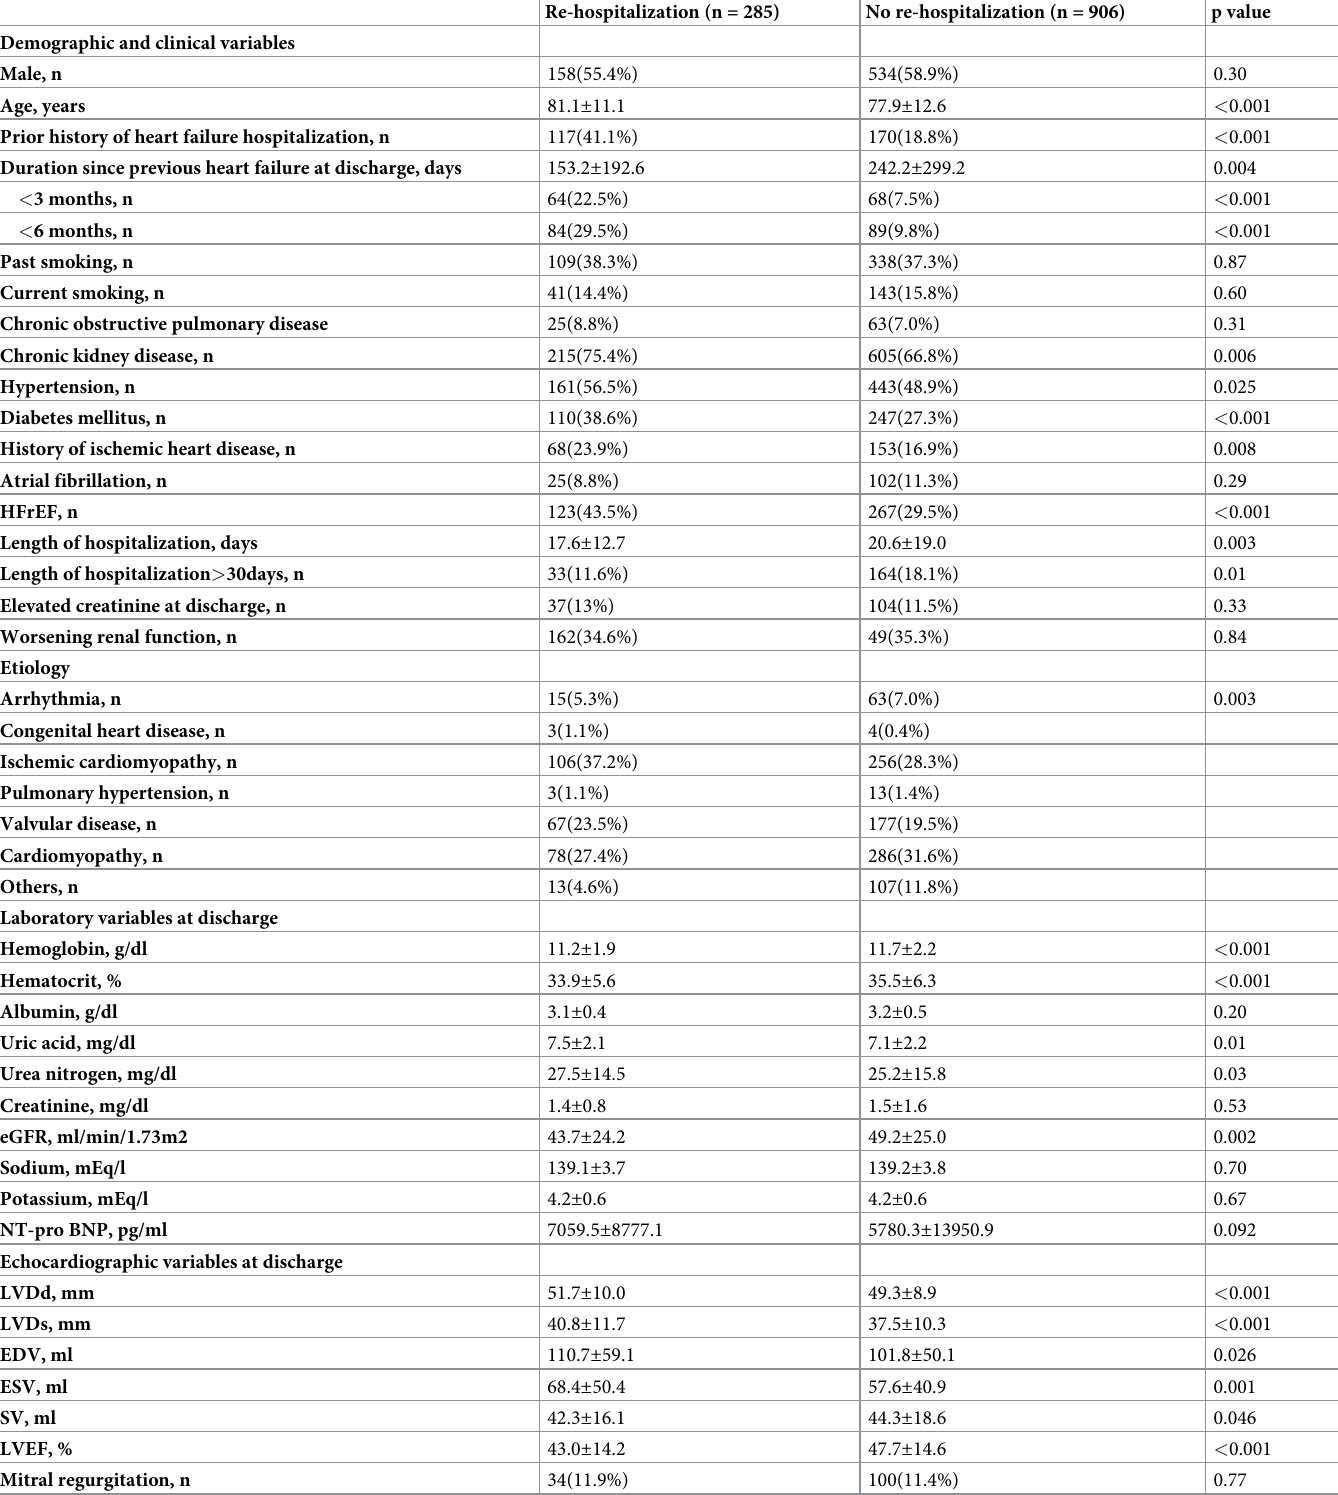
Table 1. Characteristics of